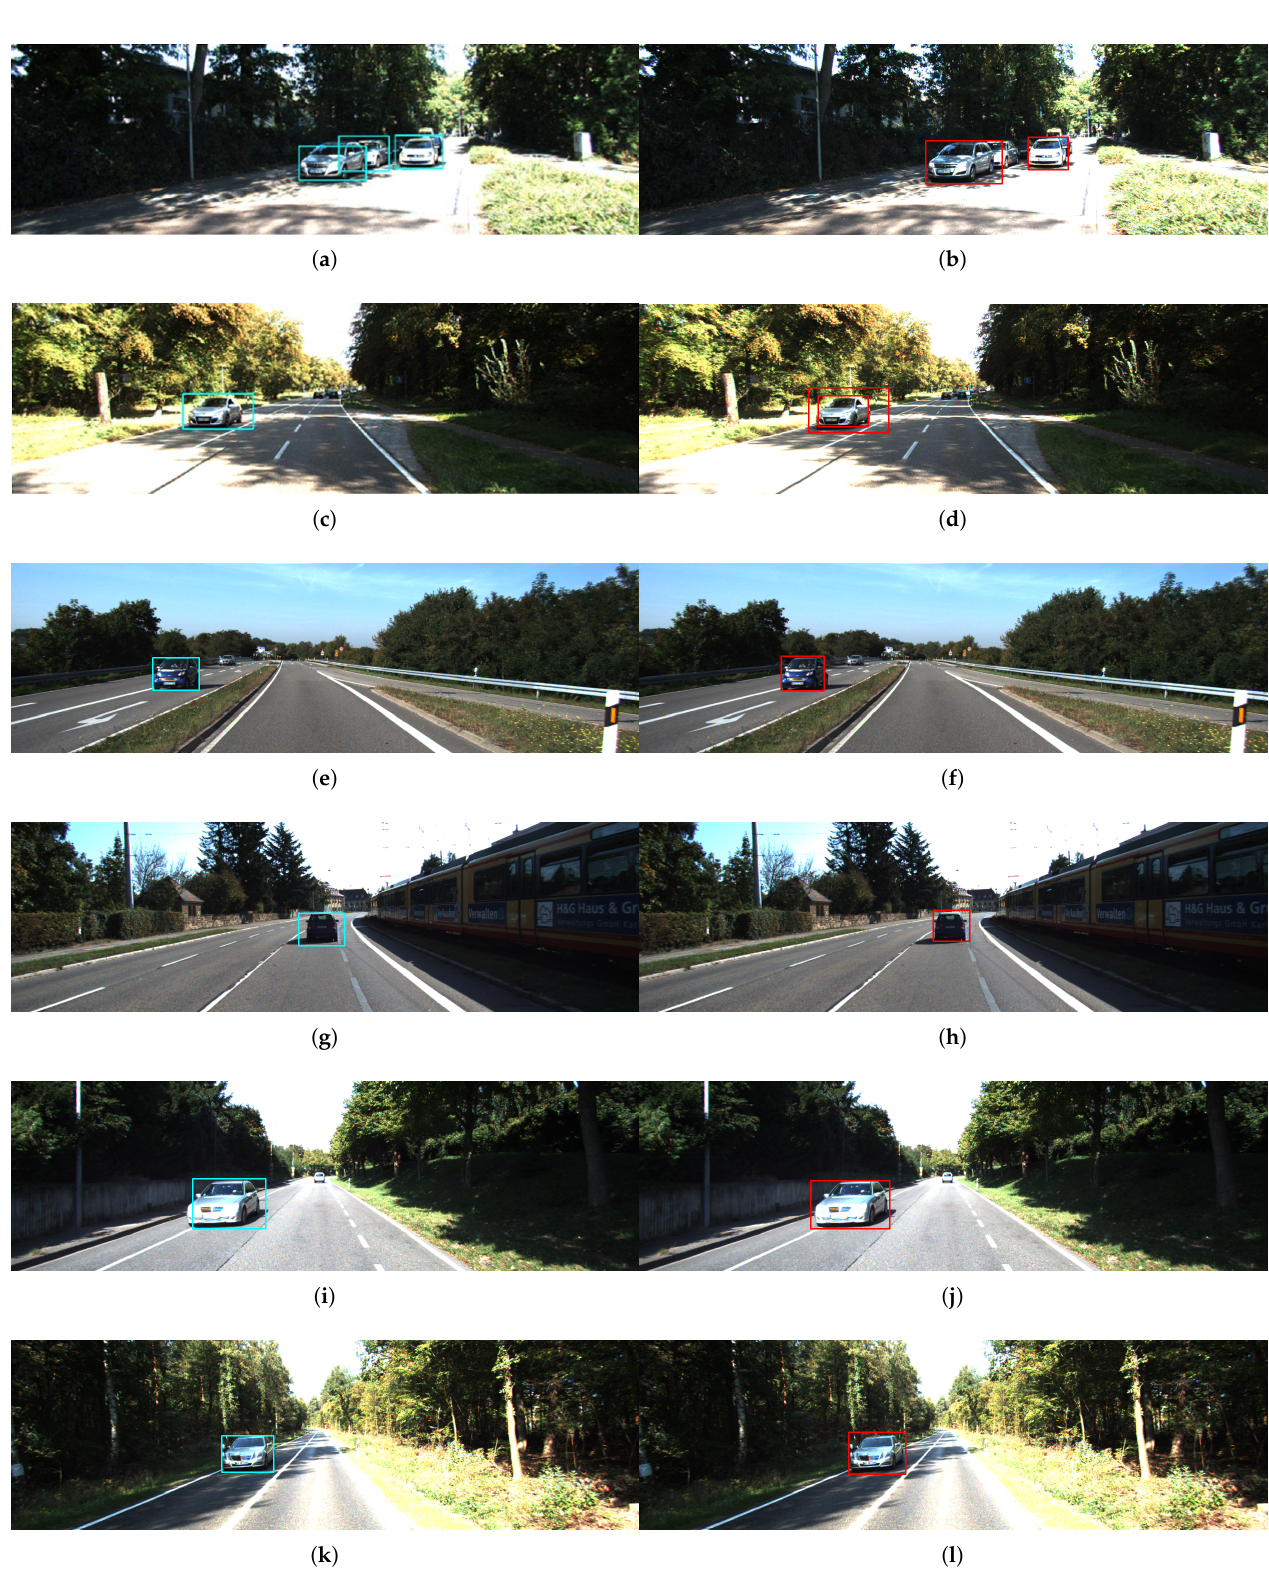
Figure 9. Qualitative vehicle detection results of our CESDD-based detector ( a , c , e , g , i , k ) vs. deformable part-based model (DPM) ( b , d , f , h , j , l ) on KITTI2017